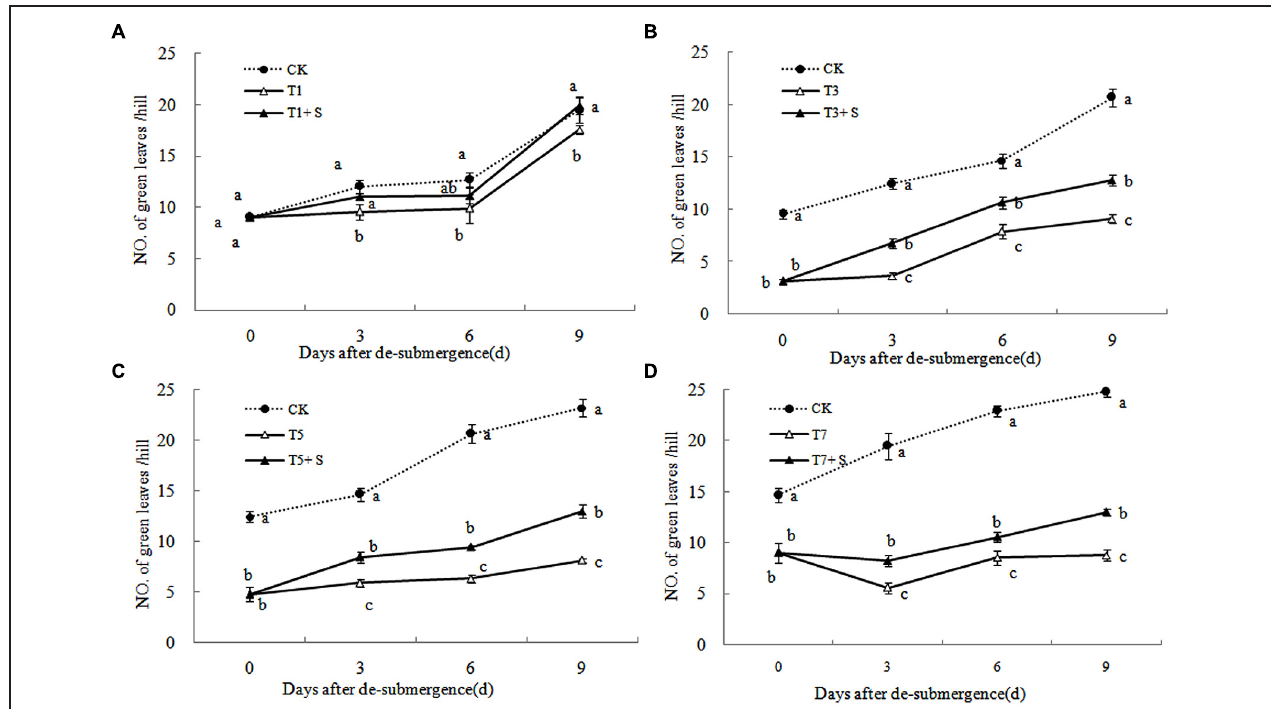
FIGURE 1 | Effects of spermidine (Spd) on green leaves number per hill of rice after submergence. CK indicate control with no submergence, T1, T3, T5, T7 indicate submerged for 1, 3, 5, 7 days, respectively. T1 + S, T3 + S, T5 + S, T7 + S indicate submerged for 1, 3, 5, 7 days and spray spermidine after drainage, respectively. The same as follow.